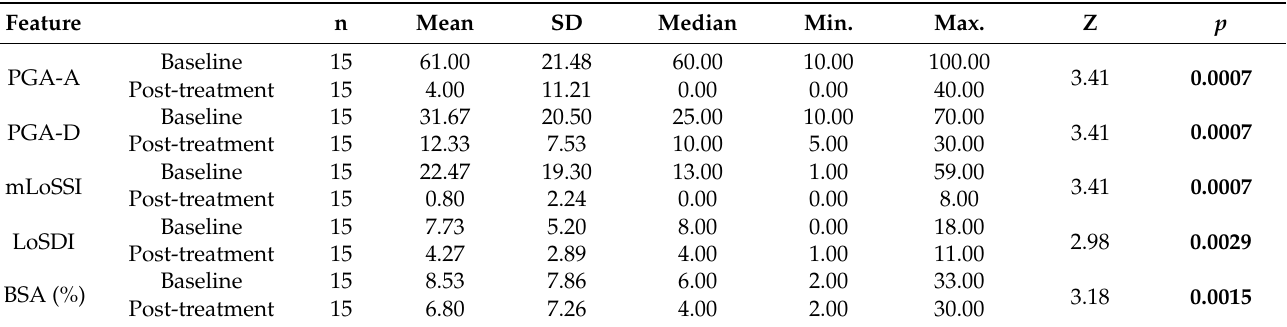
Table 8. Results of disease-targeted measures at baseline and after treatment (only topical or combined systemic GKS/MTX and topical).